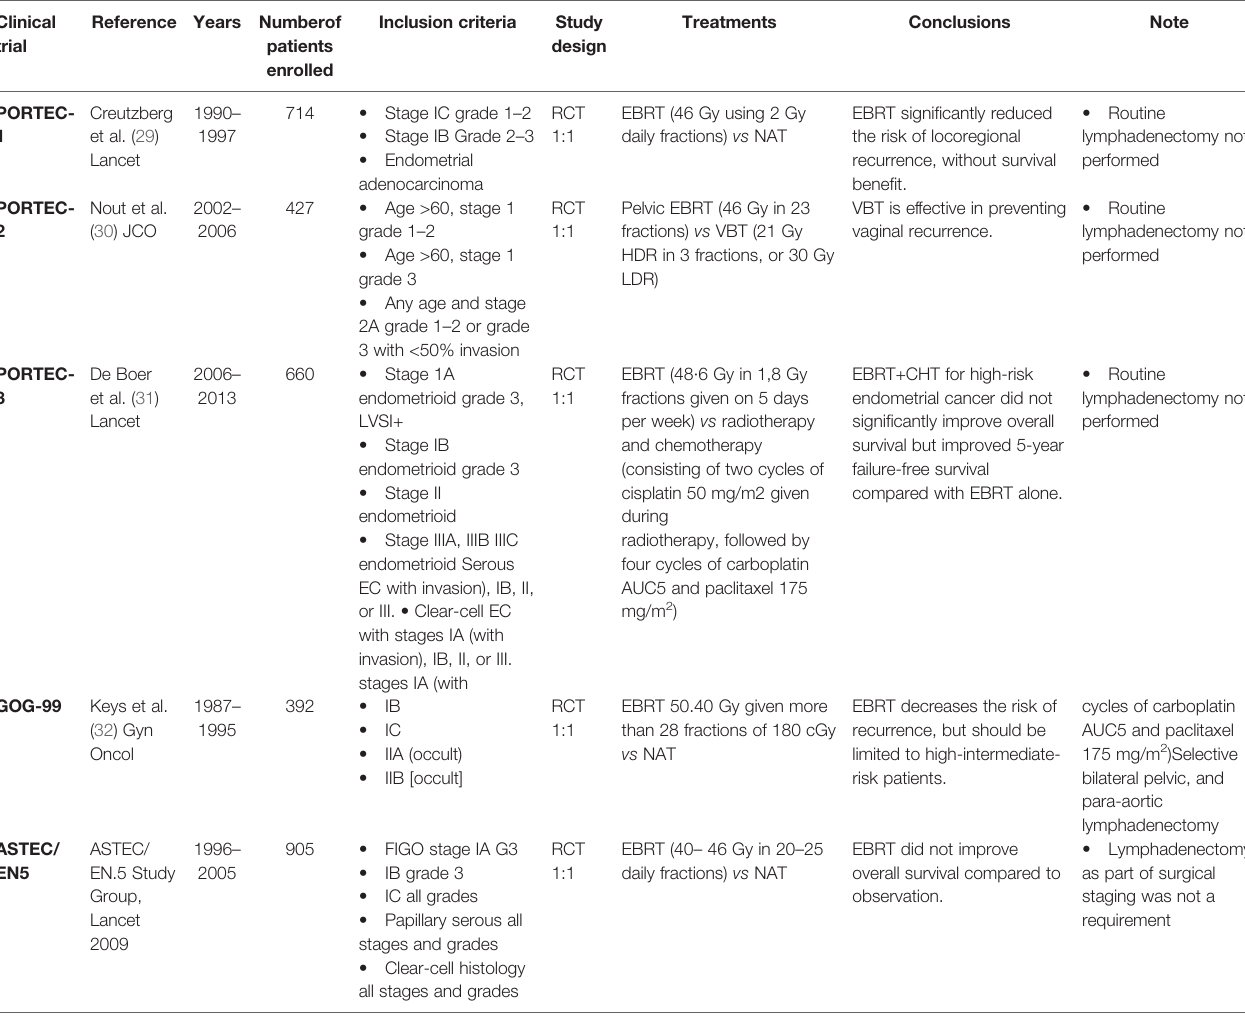
TABLE 1 | Relevant clinical trials for the ESGO/ESTRO/ESP consensus. Clinical